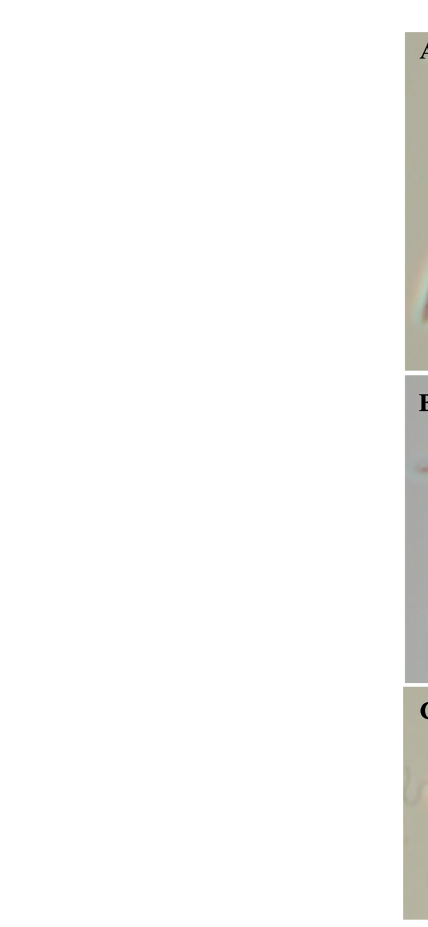
FIGURE 5 Morphology of the of LmxM.11.1240 and LmxM.11.1240/LmxM.34.0320 knockouts. (A) Parental line, L. mexicana strain T7 Cas9;